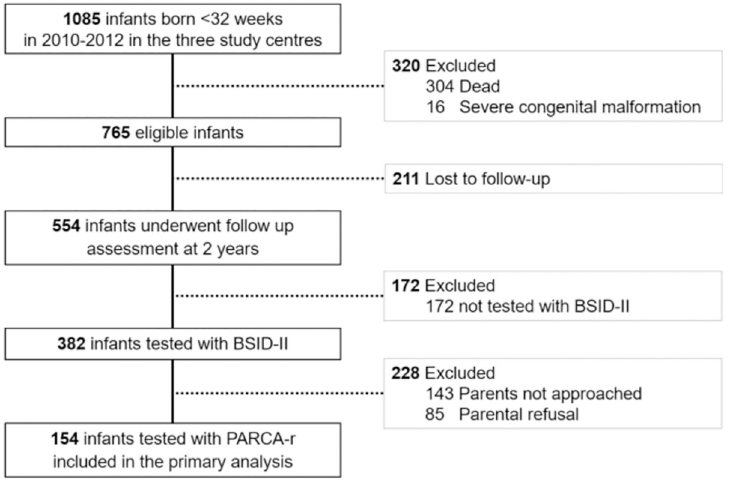
Fig 1. Study flow